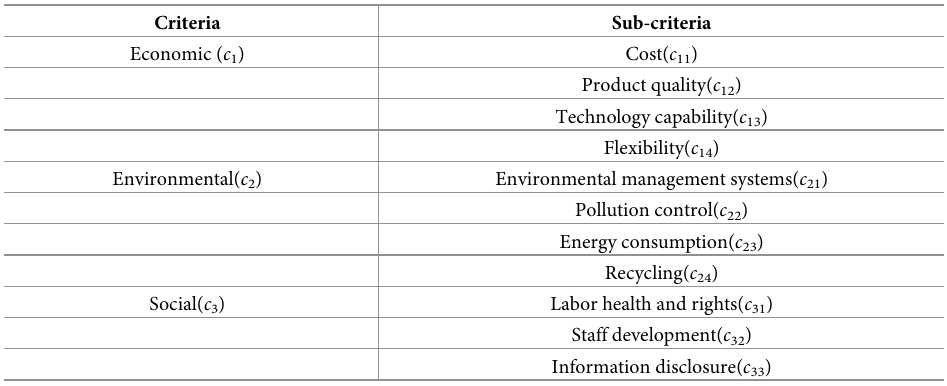
Table 3. Criteria system for